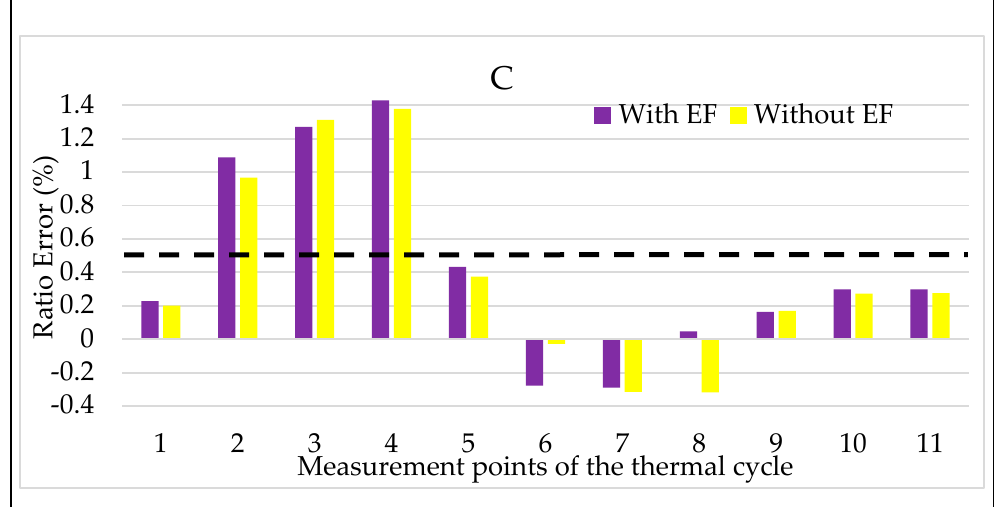
Figure 17. Ratio error vs. temperature + electric field for LPVT C.